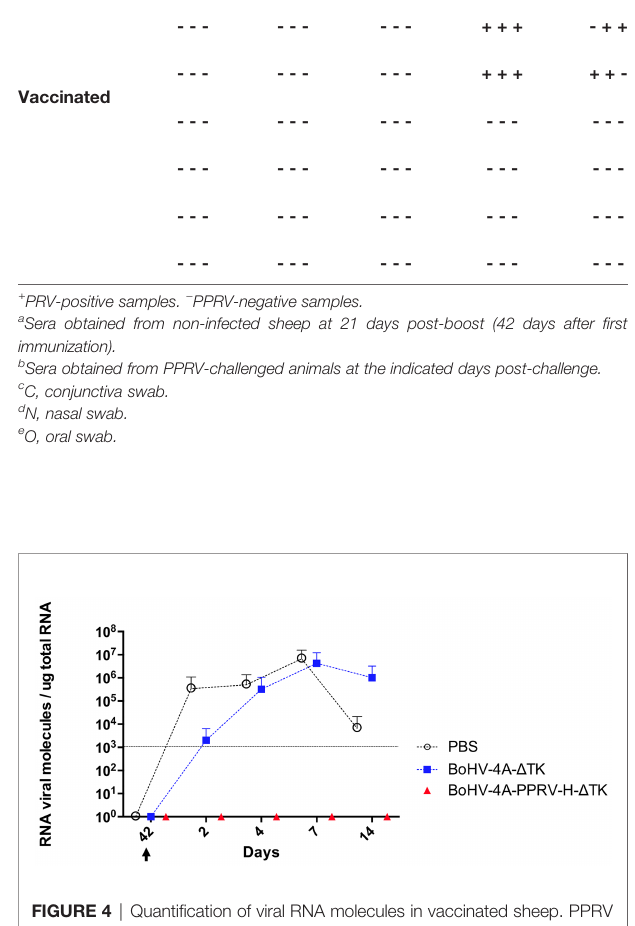
FIGURE 4 | Quanti fi cation of viral RNA molecules in vaccinated sheep. PPRV RNA molecules were quantitated by qPCR as described in the Materials and Methods . The data are represented as the mean of the RNA values obtained for the animals of the same treatment group per microgram of total blood RNA for the indicated days. The different treatment groups are indicated in the legend [PBS (black), control vector (BoHV-4-A- D TK) (blue), or BoHV-4-A- PPRV-H- D TK (red)]. Triplicates for each sample were used. Differences were found to be signi fi cant ( p < 0.05; Mann – Whitney test) between control (PBS or BoHV-4-A- D TK) and vaccinated